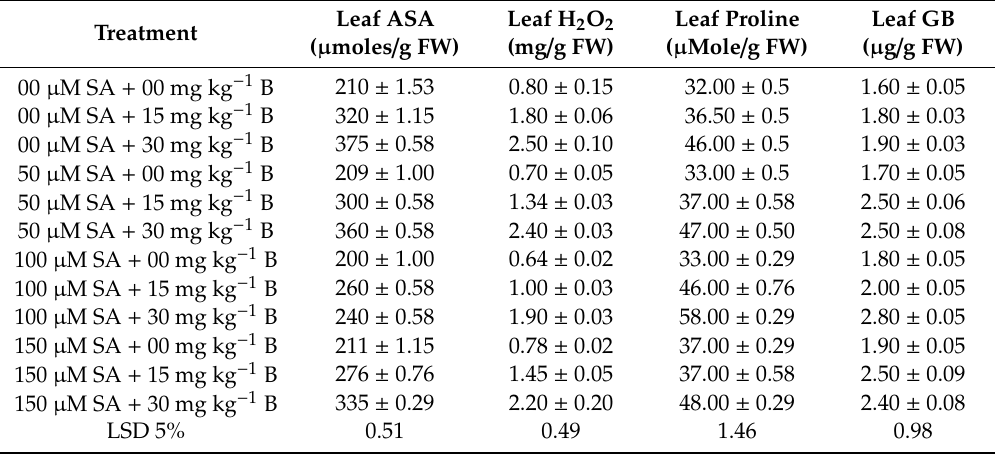
Table 3. E ff ect of SA (0, 50, 100 and 150 µ M) on the leaf ascorbic acid, H 2 O 2 , proline and glycine